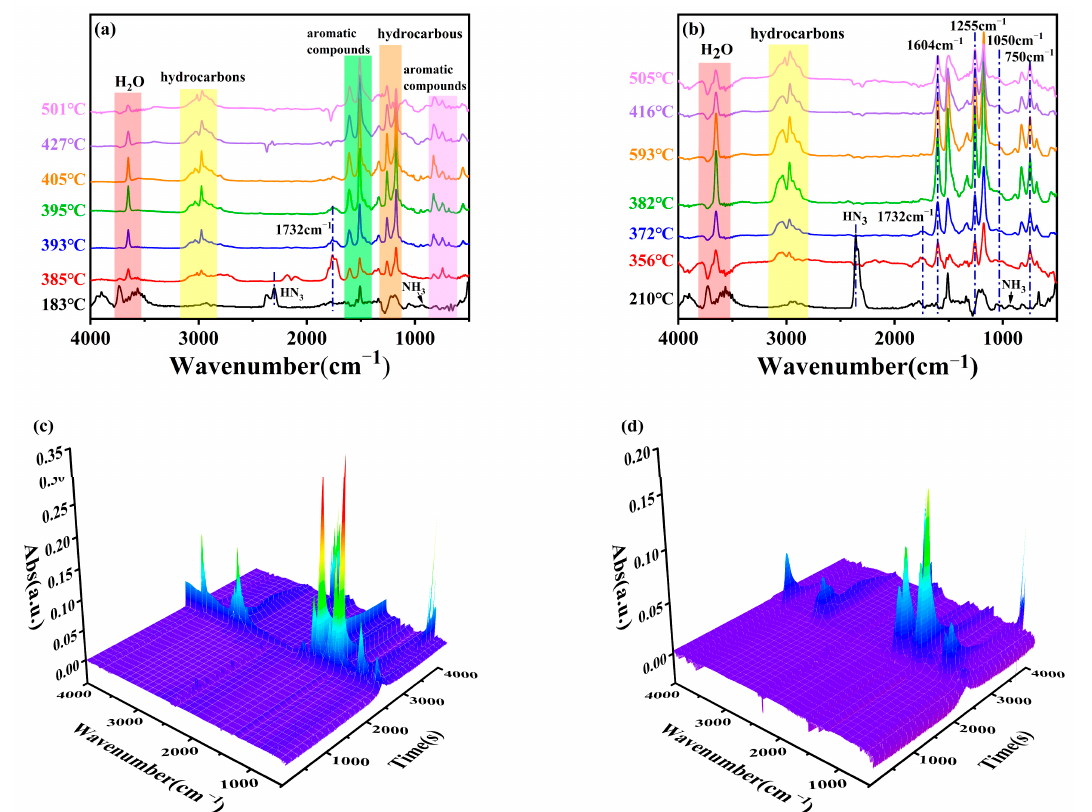
Figure 4. FTIR spectra of gaseous pyrolysis products of EP ( a ) and FREP-4 ( b ) at different tempera- tures; 3D TG-IR diagrams of EP( c ) and FREP-4 ( d ) gaseous pyrolysis products. tures; 3D TG-IR diagrams of EP ( c ) and FREP-4 ( d ) gaseous pyrolysis